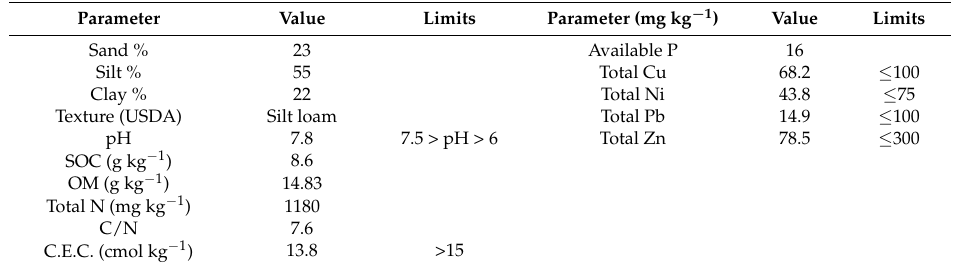
Table 6. Physical and chemical characteristics of soil at the beginning of the study before the sludge amendment and the limits defined by Italian Law for the use of sewage sludge on agricultural soil (D.L. 27 January 1992 n. 99). Concentrations refer to dry